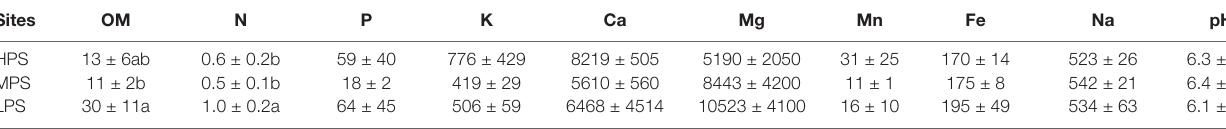
TaBlE 3 | Macro- and micro-nutrients ± standard deviation in soils (0–20 cm) of N. pumilio and N. antarctica forests from three sites with contrasting environmental conditions. Organic matter (OM) and nitrogen (N) concentrations are expressed as %, while the rest of elements are expressed as mg kg −1 . Sites